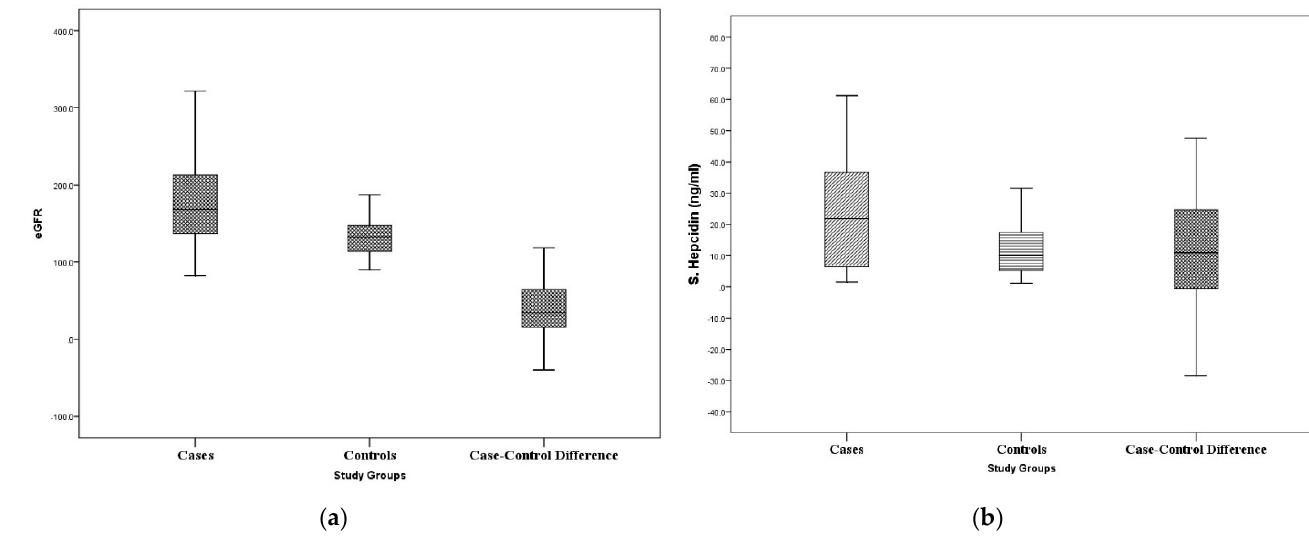
Figure 1. Comparison of ( a ) eGFR and ( b ) serum hepcidin between patients with β -thalassemia major and their matched controls.